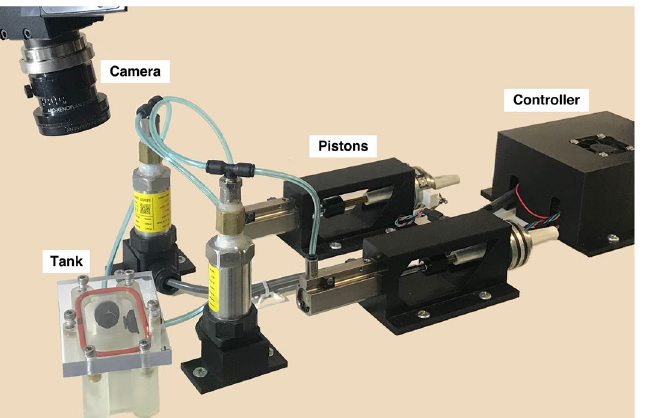
Figure 1. The test configuration is shown. Pistons provided continuous volume-controlled loads to inflate the lung test specimen, while accounting for tank air volume displacement to measure lung pressure and actual lung volume. Two overhead cameras recorded the lung specimen’s surface deformations in three dimensions to obtain DIC strain